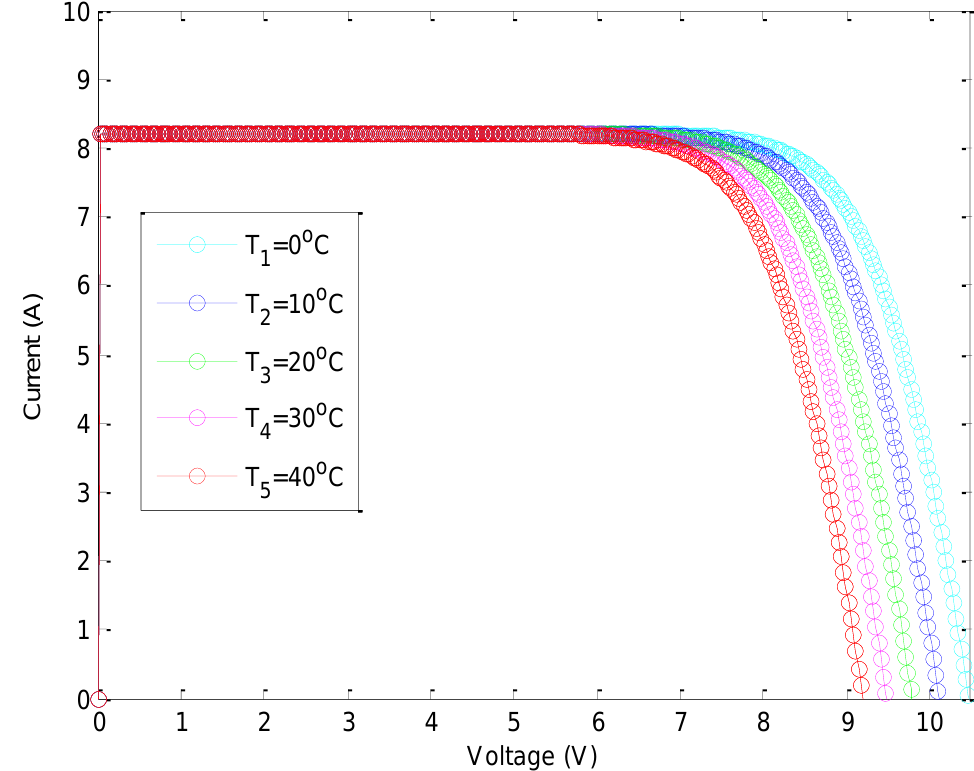
Figure 10. Current-voltage characteristic curves of photovoltaic cell for various temperature and constant